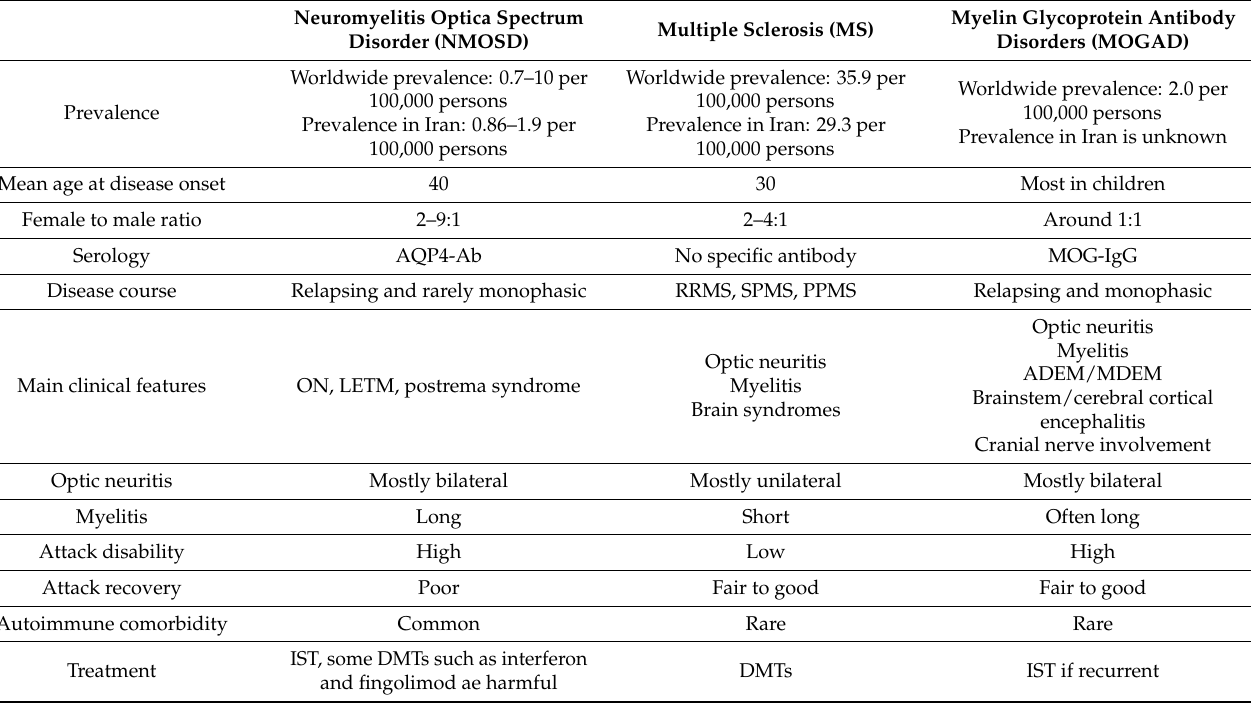
Table 1. Comparison of sociodemographic and clinical characteristics between Neuromyelitis Op- tica Spectrum Disorder (NMOSD), Multiple Sclerosis (MS), and Myelin Glycoprotein Antibody Disorders